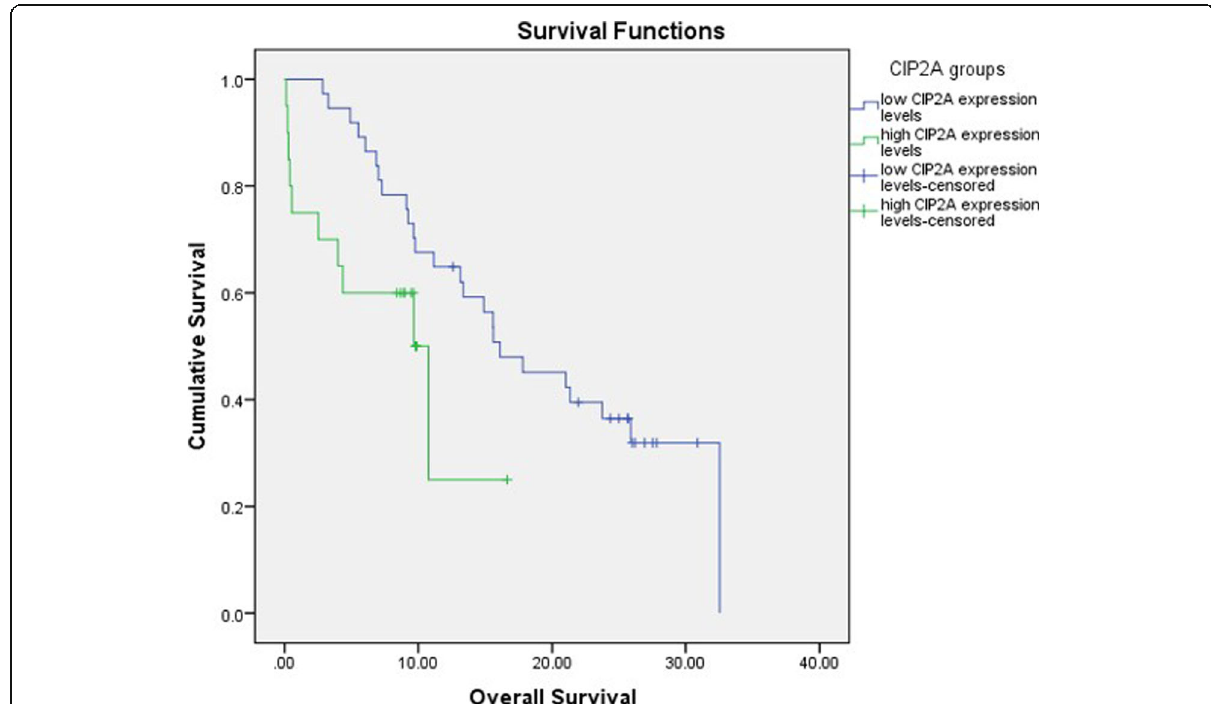
Fig. 2 Overall survival in patients with acute myeloid leukemia and high or low levels of CIP2A